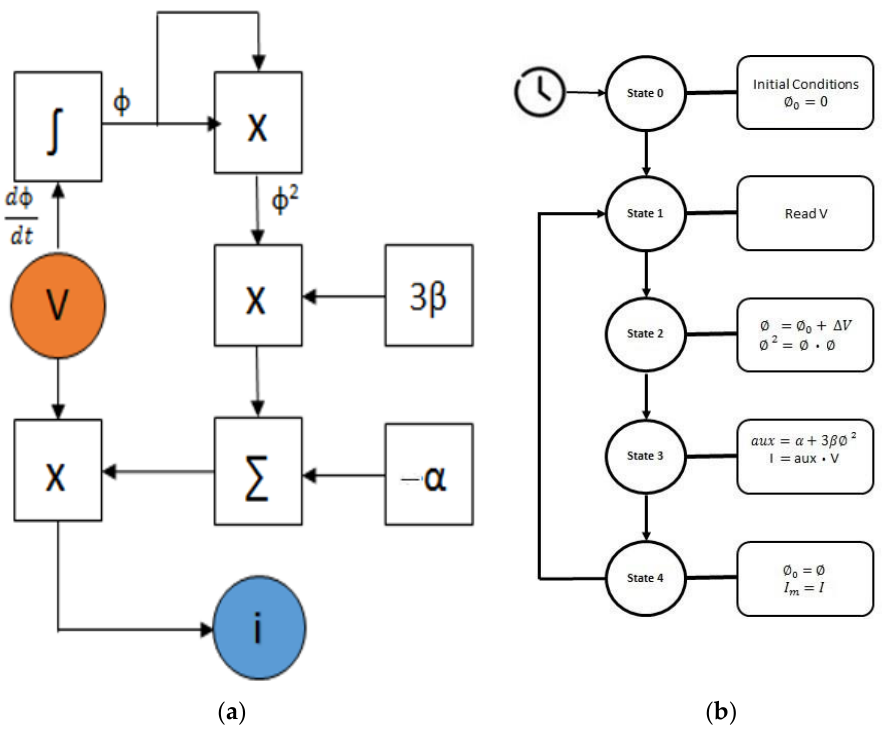
Figure 10. FPGA-based memristor solver: ( a ) Memristor solver block diagram; ( b ) Memristor solver FSM flowchart. Table 3. FPGA chip statistics, including the full system .